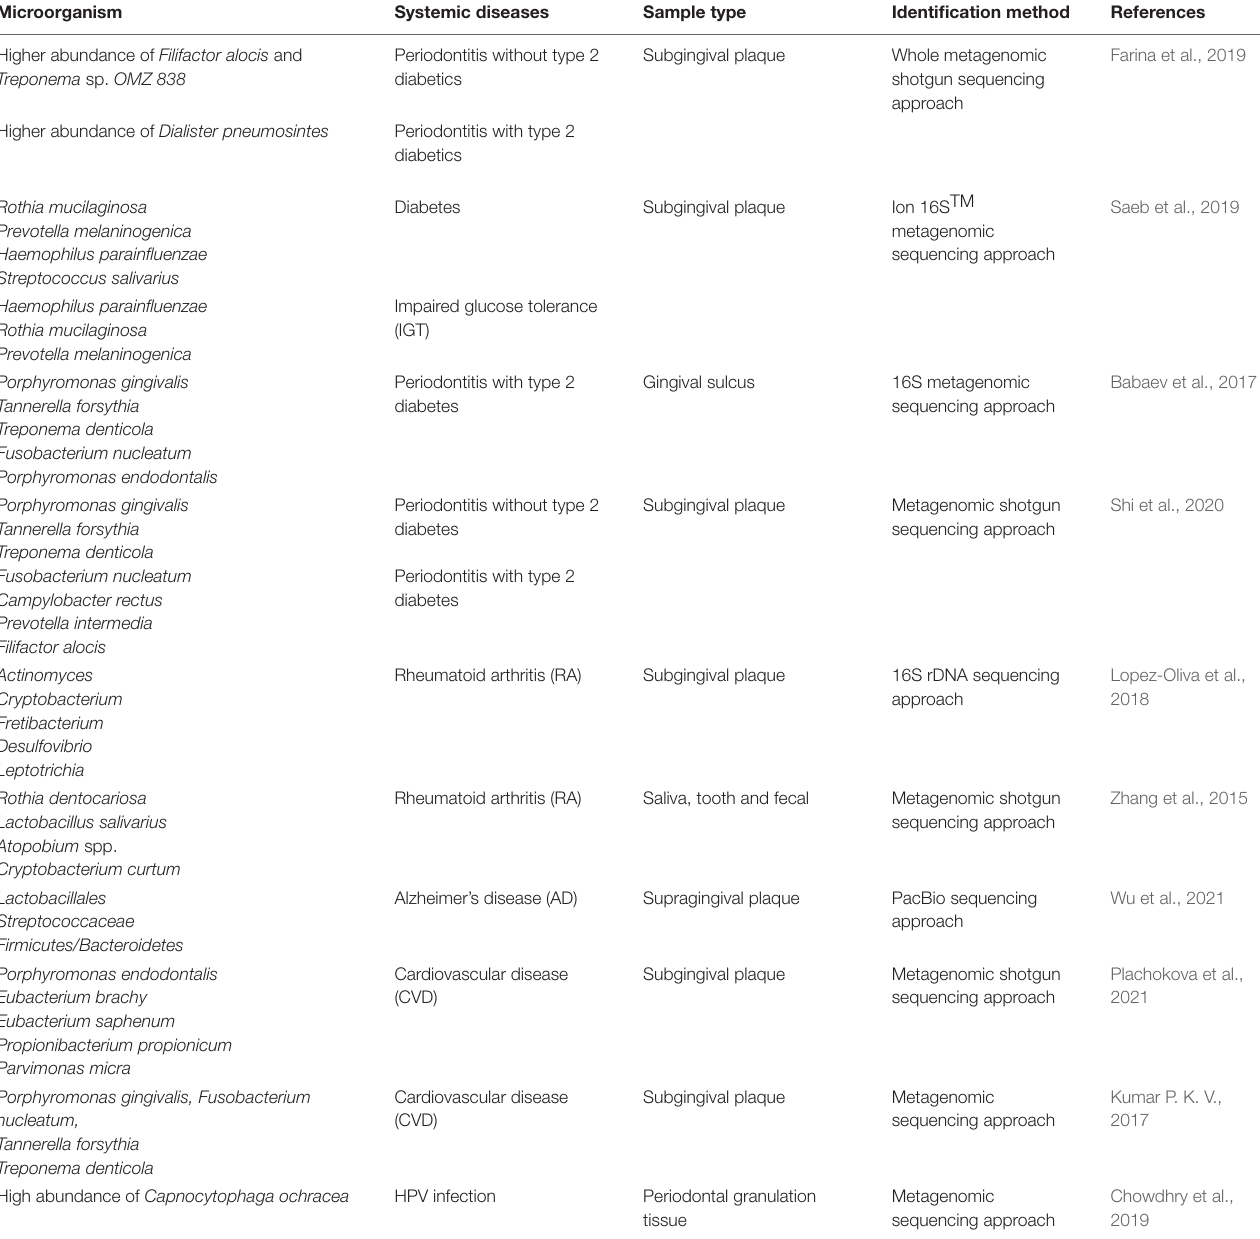
TABLE 3 | Evaluation of periodontitis related systemic diseases with metagenomics and